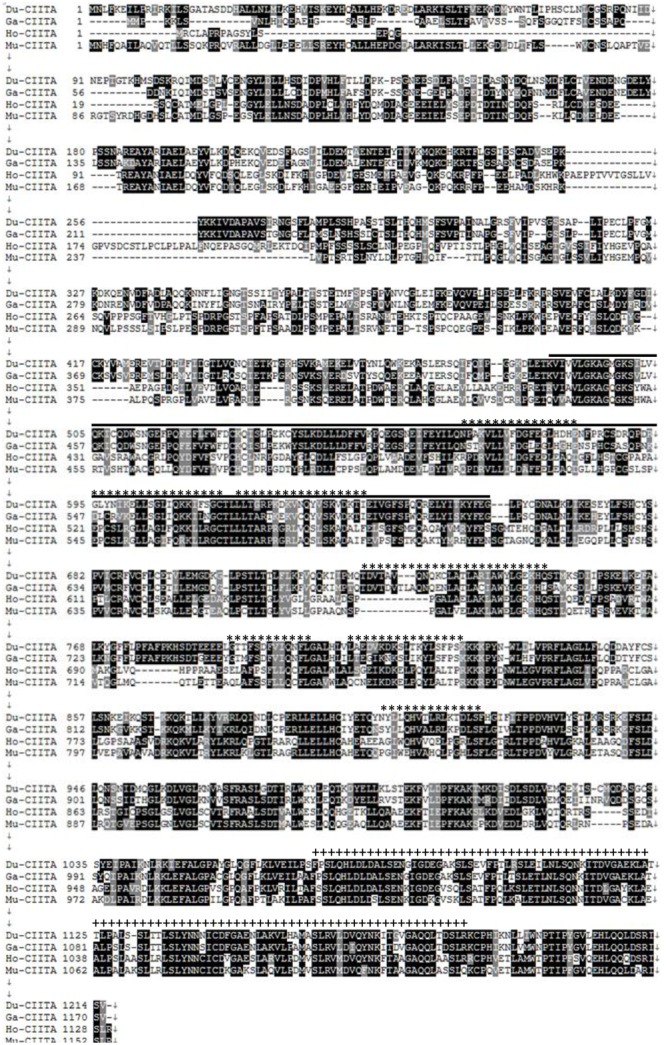
Multiple alignment of the Cherry Valley ducks CIITA. Alignment was performed using the Clustal X program and edited with Boxshade. The CIITA sequences are shown for Cherry Valley duck (Du), chicken (Ch), human (Hu), and mouse (Mu). The amino acid sequences used are seen in Table 2. Black shading indicates amino acid identity; gray shading indicates similarity (50% threshold); the black line represents the NACHT domain; the ∗∗∗ above the sequence represents the seven predicted transactivator domains; the +++ above the sequence represents the four LRR domains.